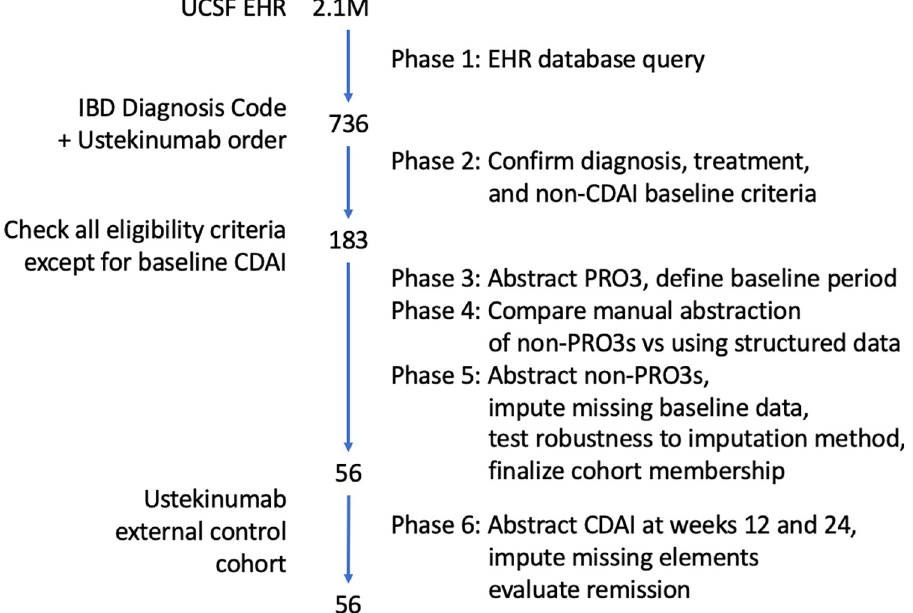
Fig 1. Study flow diagram. 736 patient records were screened for inclusion, 56 records met all study criteria. Sequential definition of the cohort described on the left, methods for defining the cohort by study phase summarized on the